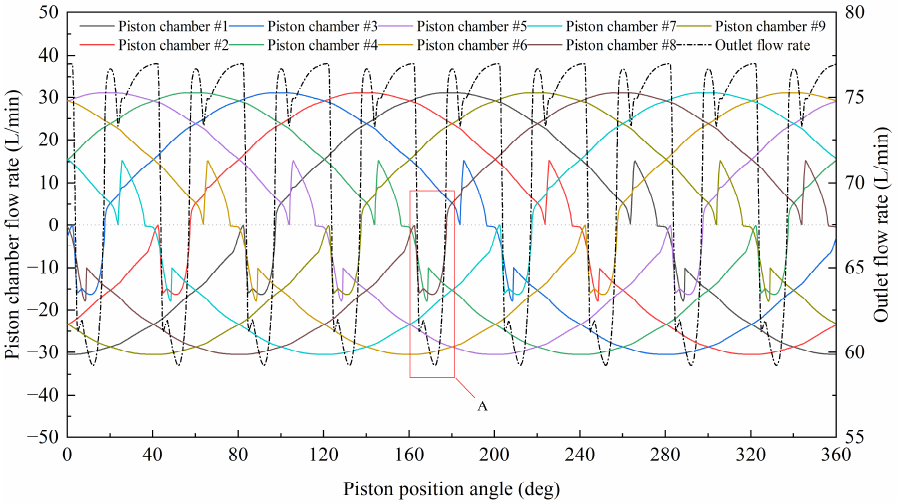
Figure 22. Dynamic flow characteristics of the piston pump and piston chambers in one cycle.